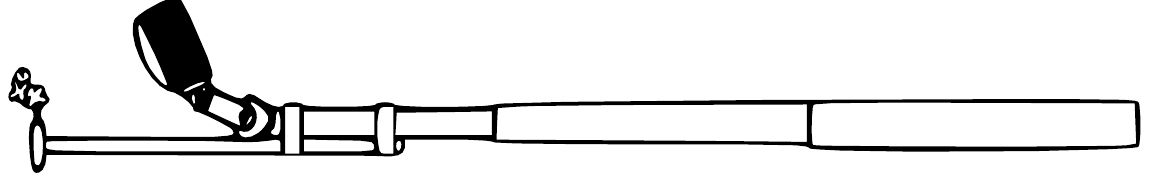
Figure 2. Stylized drawing of an interview bouquet stick (1 m long). The camera, with macro lens, is focused on a female canola inflorescence placed in a microcentrifuge